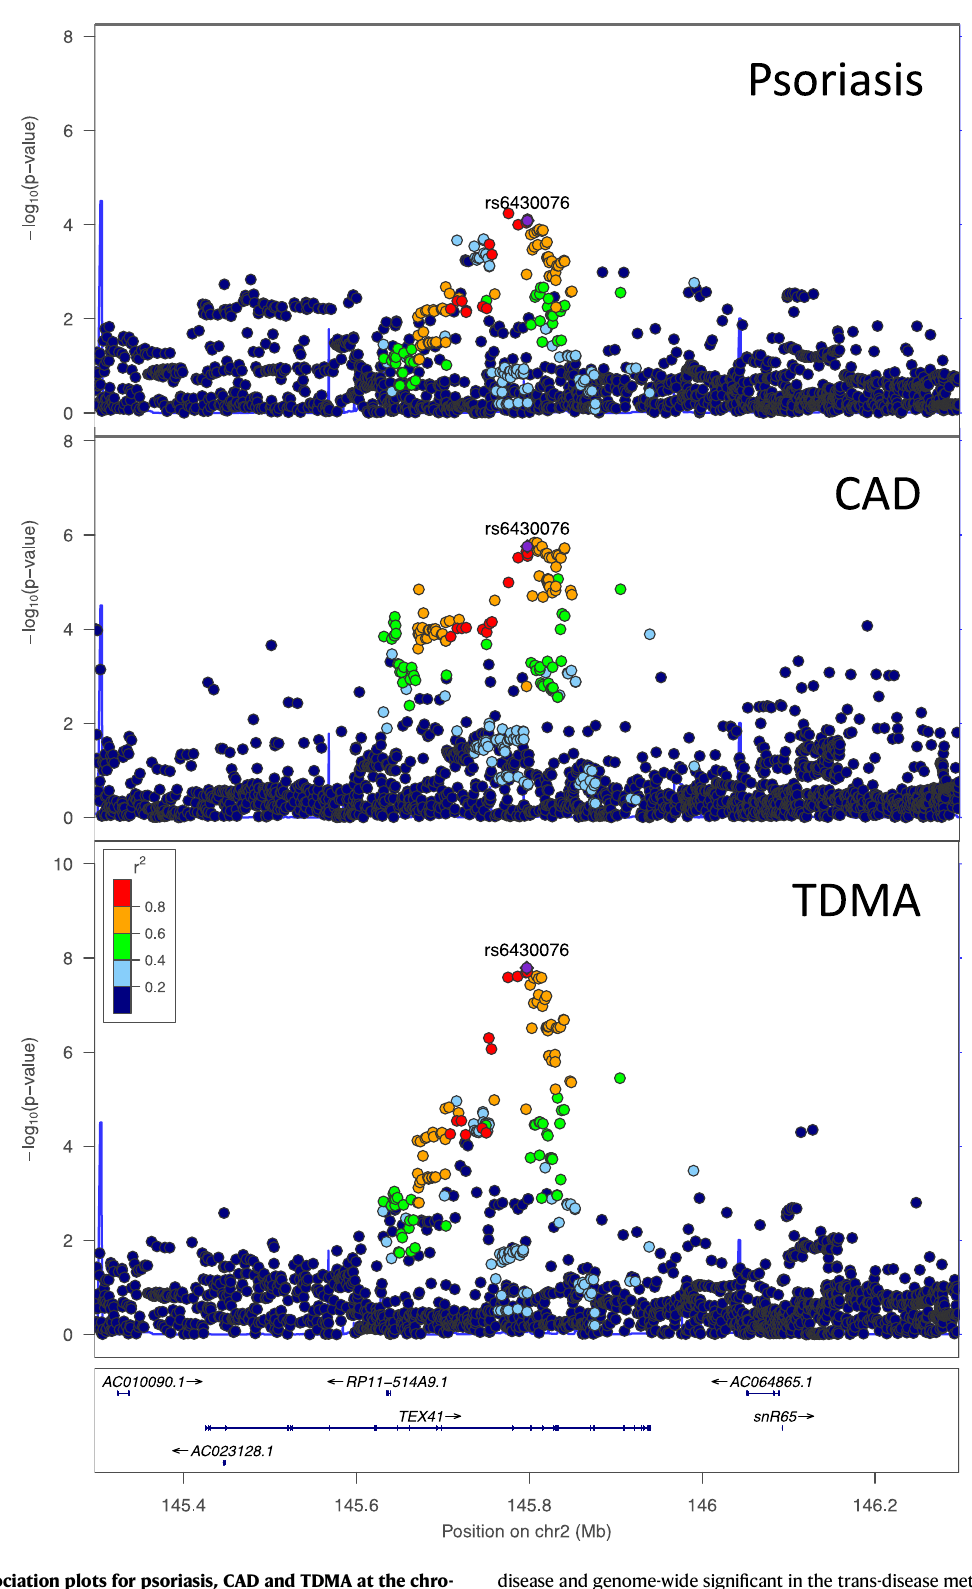
disease and genome-wide signi fi cant in the trans-disease meta-analysis, with the lead marker from TDMA indicated in